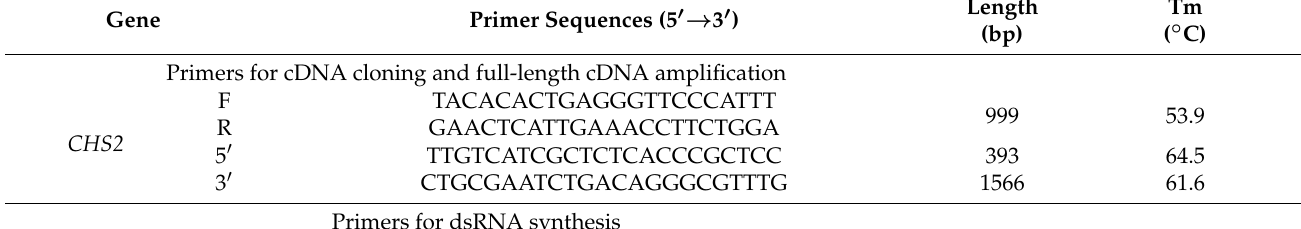
Table 1. Primers used in cDNA cloning, dsRNA synthesis, and real-time quantitative PCR.